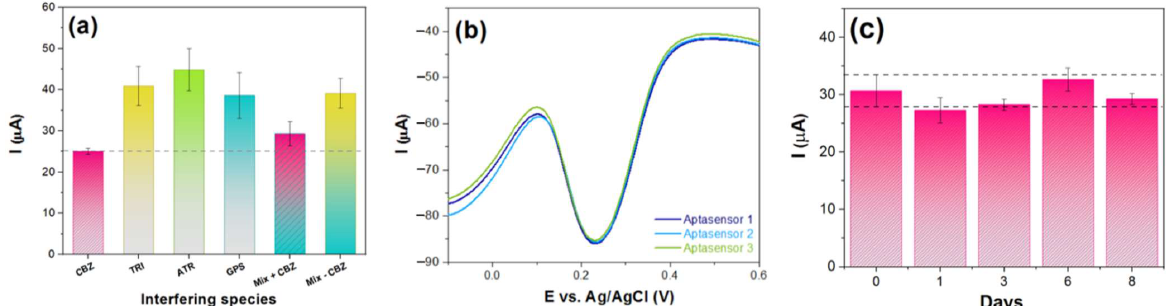
Figure 4. ( a ) Evaluation of the selectivity of the aptasensor against different interfering pesticides; ( b ) evaluation of the reproducibility of the aptasensors with 30 nM CBZ in 0.1 M PBS (pH 7.4), and ( c ) evaluation of the stability of the aptasensor for CBZ after stored for 1–8 days. All measurements were performed in triplicate.